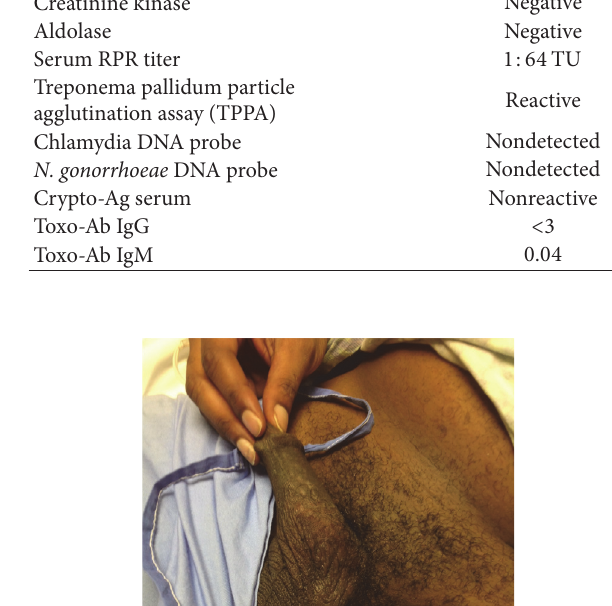
Figure 1: Photograph demonstrating a maculopapular rash dis- tributed on the palms of hand bilaterally.